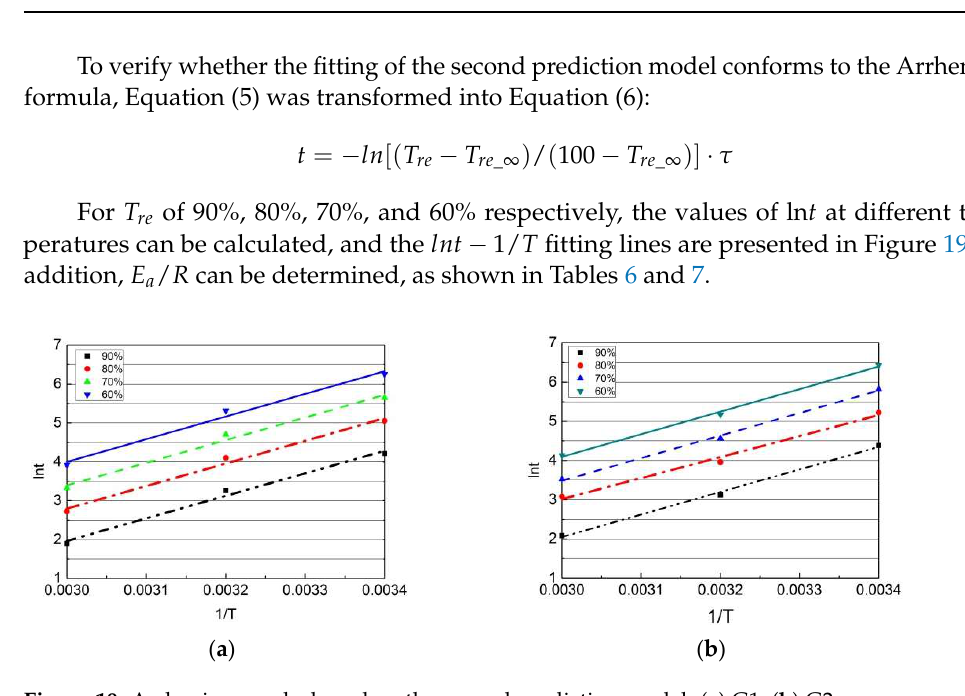
Figure 19. Arrhenius graphs based on the second prediction model: ( a ) G1; ( b ) G2. Table 6. Values of 𝐸 (cid:3028) 𝑅⁄ (G1) based on the second prediction model.